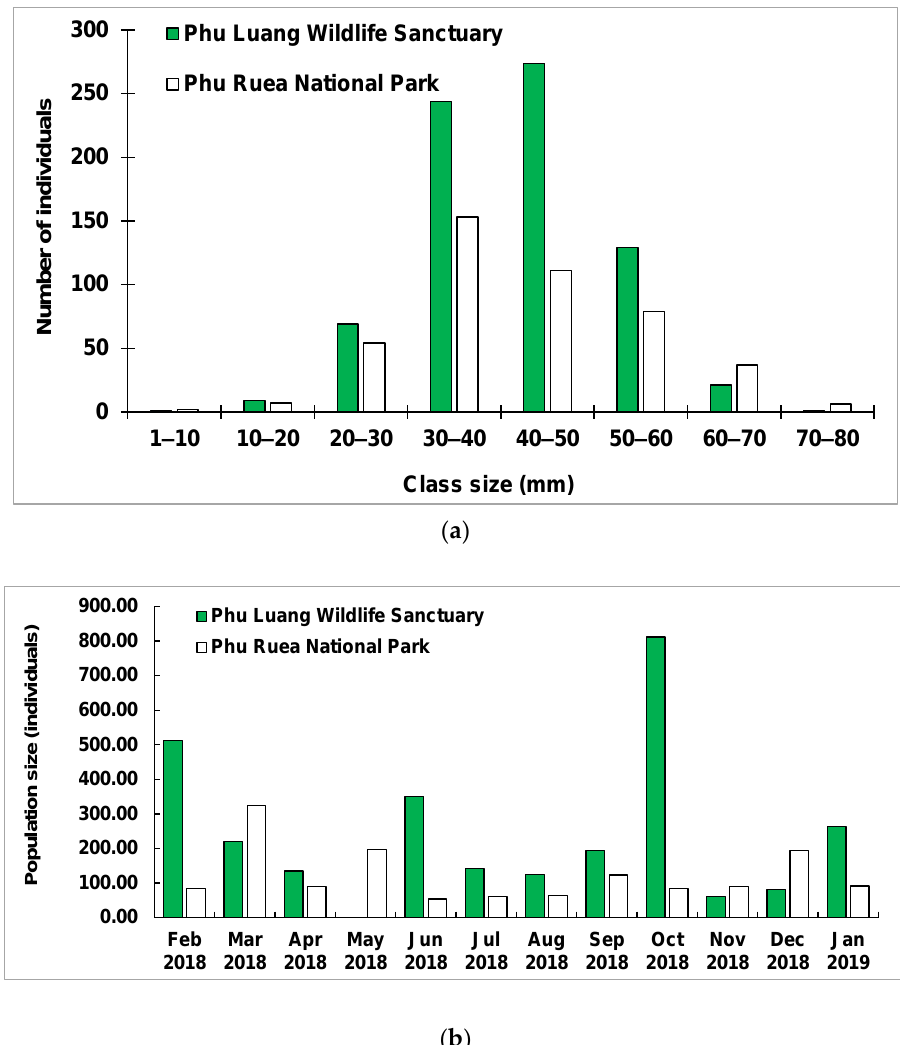
Figure 5. Size frequency distribution using carapace width ( a ); and population of I. bhumibol in Phu Luang Wildlife Sanctuary and Phu Ruea National Park ( b ).